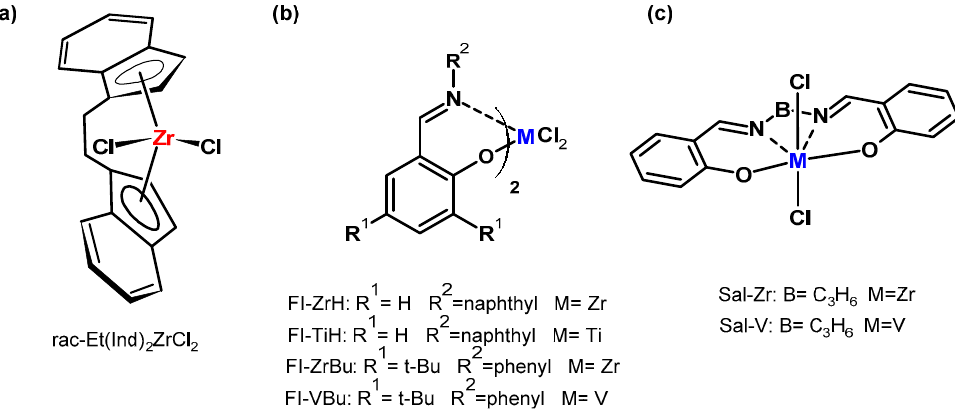
Figure 7. Structures of complexes: ansa -metallocene ( a ), bis (phenoxyimine) ( b ), salen type ( c ) used in copolymerization of ethylene with POSS [71–75].